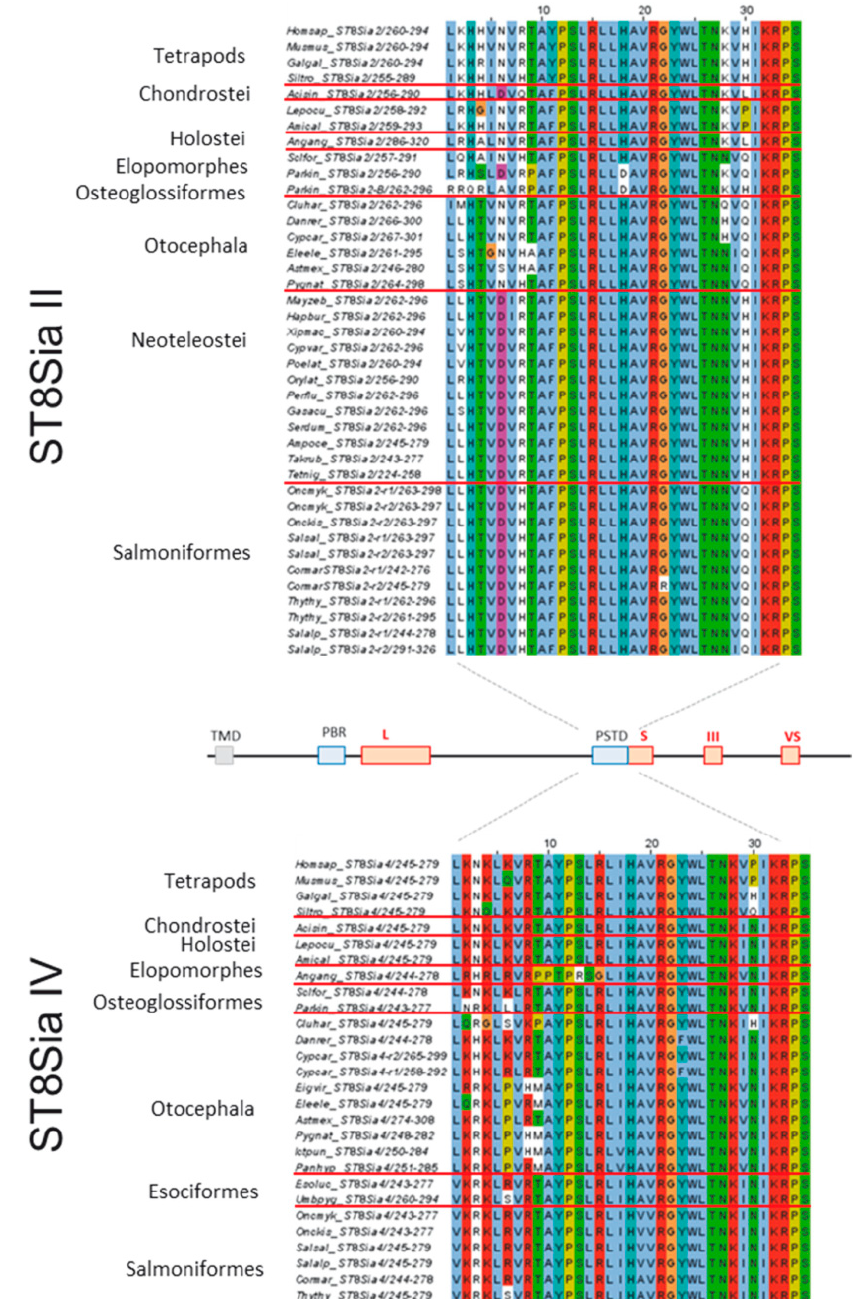
Figure 6. Sequence-based analysis of the polysialyltransferase domain (PSTD) in fish ST8Sia II and ST8Sia IV. Multiple sequence alignment of PSTD were performed with CLUSTAL OMEGA of EMBL-EBI by MUSCLE (3.8) edited and annotated in Jawa Alignment Jalview [67]. The used protein entries from di ff erent species are listed in Supplemental Table S1. The di ff erent colors from Clustal X scheme codes indicate the following characteristics: hydrophobic (blue), positive charge (red), negative charge (magenta), polar (green), cysteine (pink), glycine (orange), proline (yellow), aromatic (cyan), and gap (white). It should be noted that one additional amino acid was added to the N-terminus and two additional amino acids to the C-terminus of PSTD.